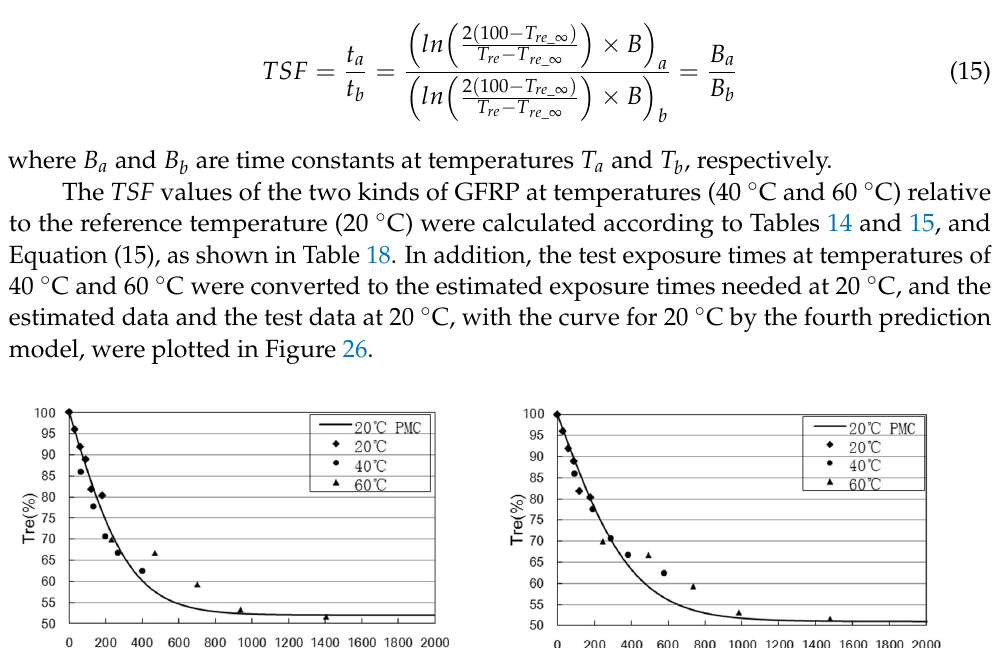
Table 18. TSF at temperatures of 20, 40, and 60 °C based on the fourth prediction model .